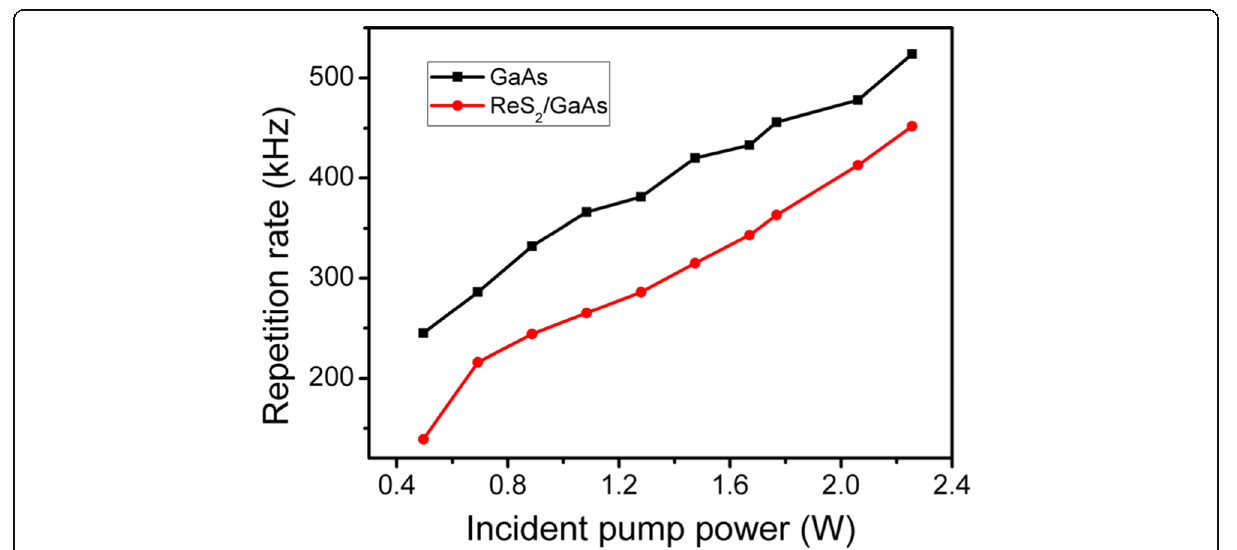
Fig. 5 Repetition rate of the passively Q-switched laser versus the incident pump power